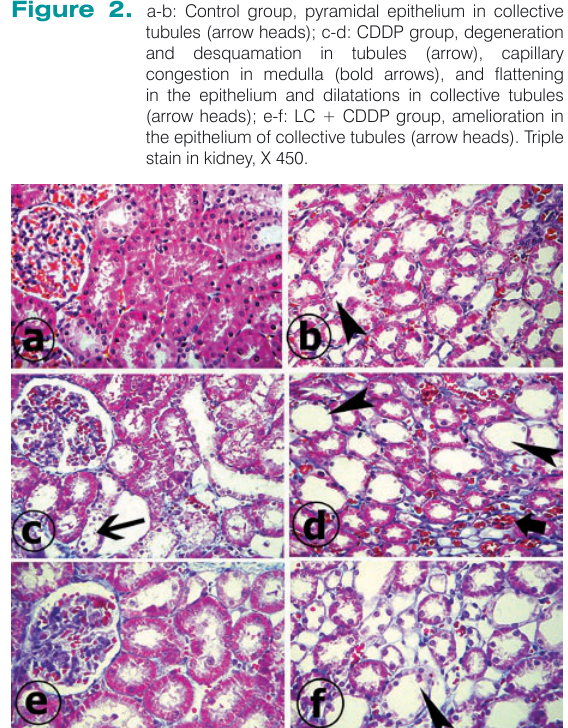
Figure 2. a-b: Control group, pyramidal epithelium in collective tubules (arrow heads); c-d: CDDP group, degeneration and desquamation in tubules (arrow), capillary congestion in medulla (bold arrows), and flattening in the epithelium and dilatations in collective tubules (arrow heads); e-f: LC + CDDP group, amelioration in the epithelium of collective tubules (arrow heads). Triple stain in kidney, X